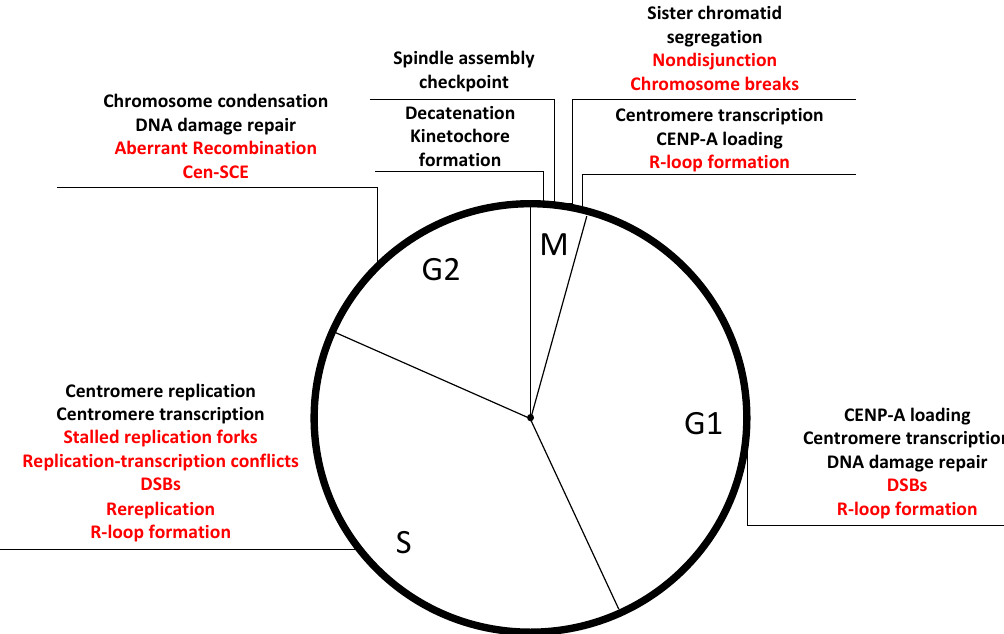
Figure 2. Cell-cycle-associated events that may destabilize human centromeres. Major cell cycle events and checkpoints are indicated at their respective location in the cell cycle in black, and potential sources of centromeric instability are shown in red. (G1) In the early stages of G1, centromeres are transcribed, and CENP-A is loaded. Close regulation of transcription is essential for loading CENP- A at the correct locus and in the correct amount, and incorrect loading of CENP-A may compromise centromere stability. (S) Replication of centromeric DNA may induce DNA instability due to stalled replication forks caused by unresolved secondary structures, re-replication of highly repetitive DNAs, and DSBs induced by replication fork collapse, torsional stress of secondary structure resolution, and/or unwinding. Centromere transcription in S-phase can lead to replication and transcription conflicts and